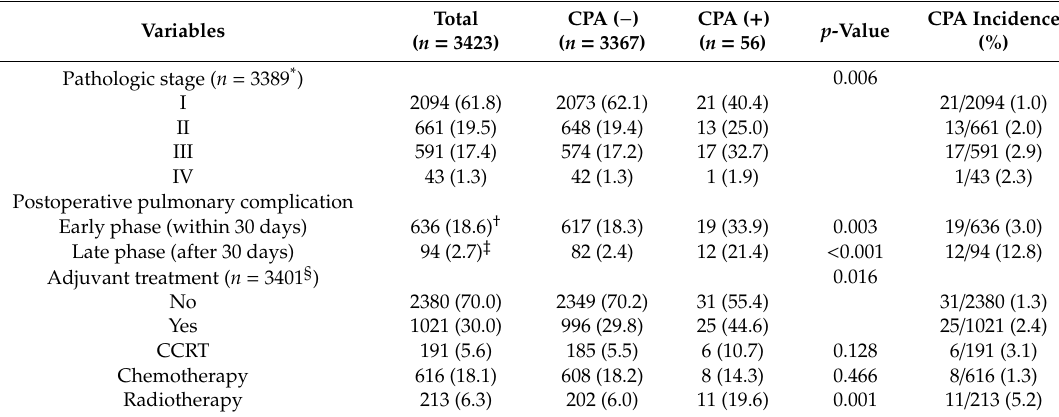
Figure 1. Selection of the study population. NSCLC, non-small-cell lung cancer; CPA, chronic pulmonary aspergillosis.